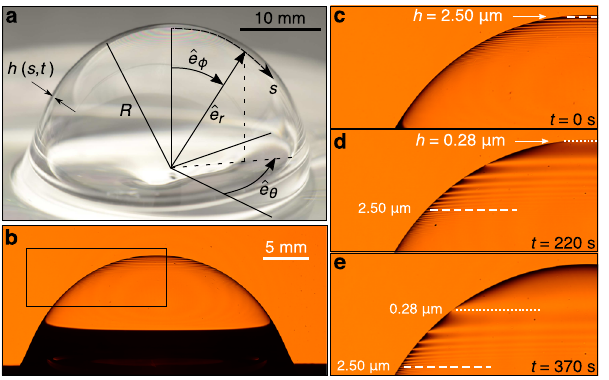
Fig. 1|Drainageofalargebubbleonthesurfaceofasiliconeoilbath. a Whena bubblerisestothebath ’ ssurface,ittrapswithitathinliquid fi lmofthickness h ( s , t ), which varies with the arc length s and time t . Based on the hemispherical shape of the bubble, the drainage dynamics can be analyzed using a spherical coordinate system in the radial, polar, and azimuthal directions ð ^ e r , ^ e ϕ , ^ e θ Þ . b Illuminating the bubble with a monochromatic sodium lamp, we observe the appearance of bright and dark fringes. c At t =0 s, the ninth to last fringe with a constant thickness of h =2.50 μ m appears at the top of the bubble. d At t =220s, the fringe has moved further down the bubble, while the last bright fringe appears at the top with a thicknessof h =0.28 μ m. e At t =370s,thetwohighlightedfringeshavepropagated towards the bubble ’ s base and a black fi lm appears at the apex. Here the bubble radius is R =12mm and the viscosity is μ =2300Pas.